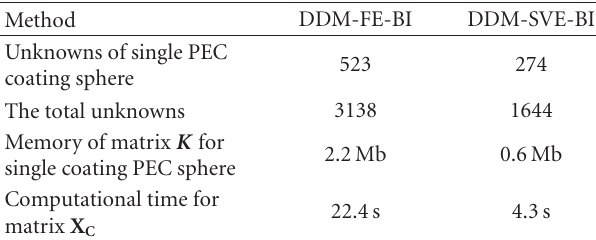
Figure 7: The Bistatic RCS of 3 × 2 array of coating PEC spheres. Table 1: The comparison of the DDM-FE-BI and DDM-SVE-BI. Bistatic RCS of 3 × 2 array of coating PEC spheres. (mesh density with λ 0 /